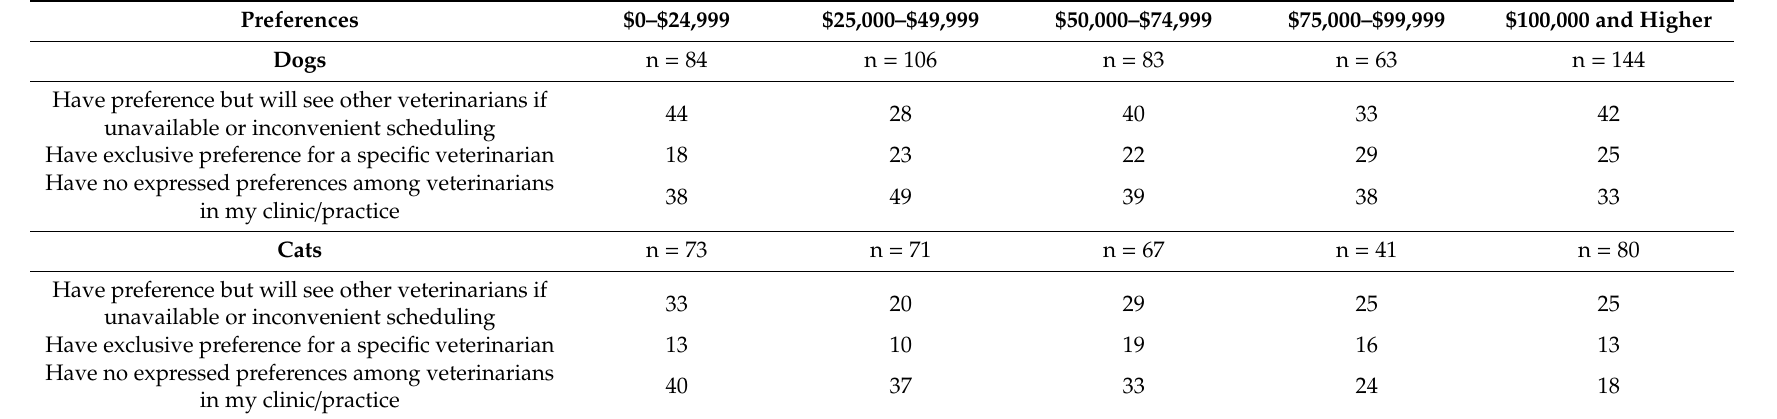
Table A4. Preferences for specific veterinarian(s) within the clinic / practice respondent visits.